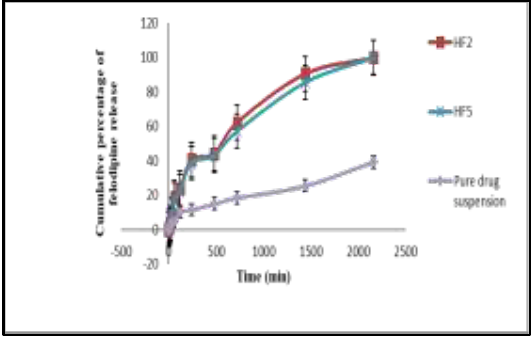
Figure 5. In vitro felodipine release profile from LPHNs formulations HF2,HF5 and the pure drug suspension at phosphate buffer pH 6.8 + 0.3 % polysorbate 80 solutions.